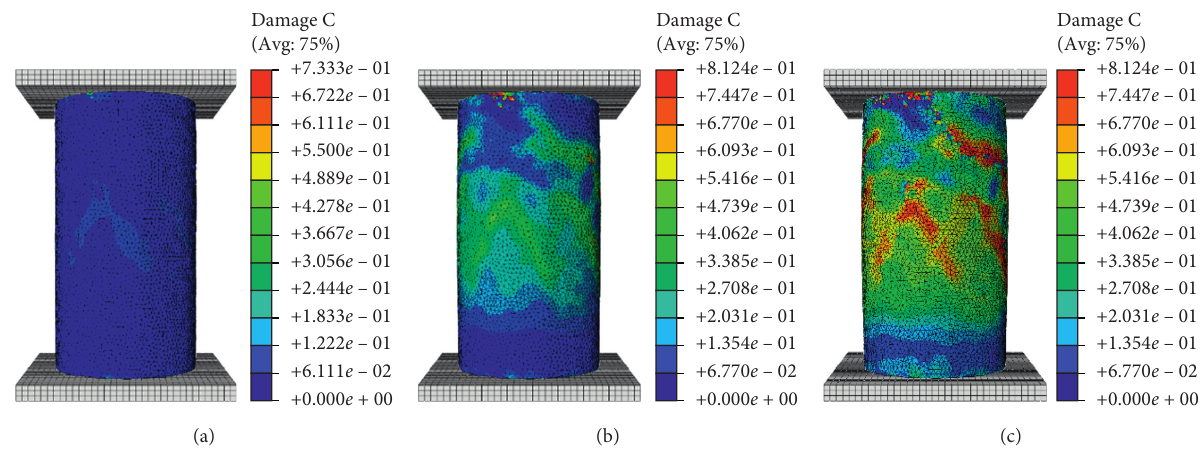
Figure 16: Compression damage nephogram of rock sample subjected to pH � 1 HCl for 90 days. (a) The initial stage of compression. (b) The middle stage of compression. (c) The later stage of